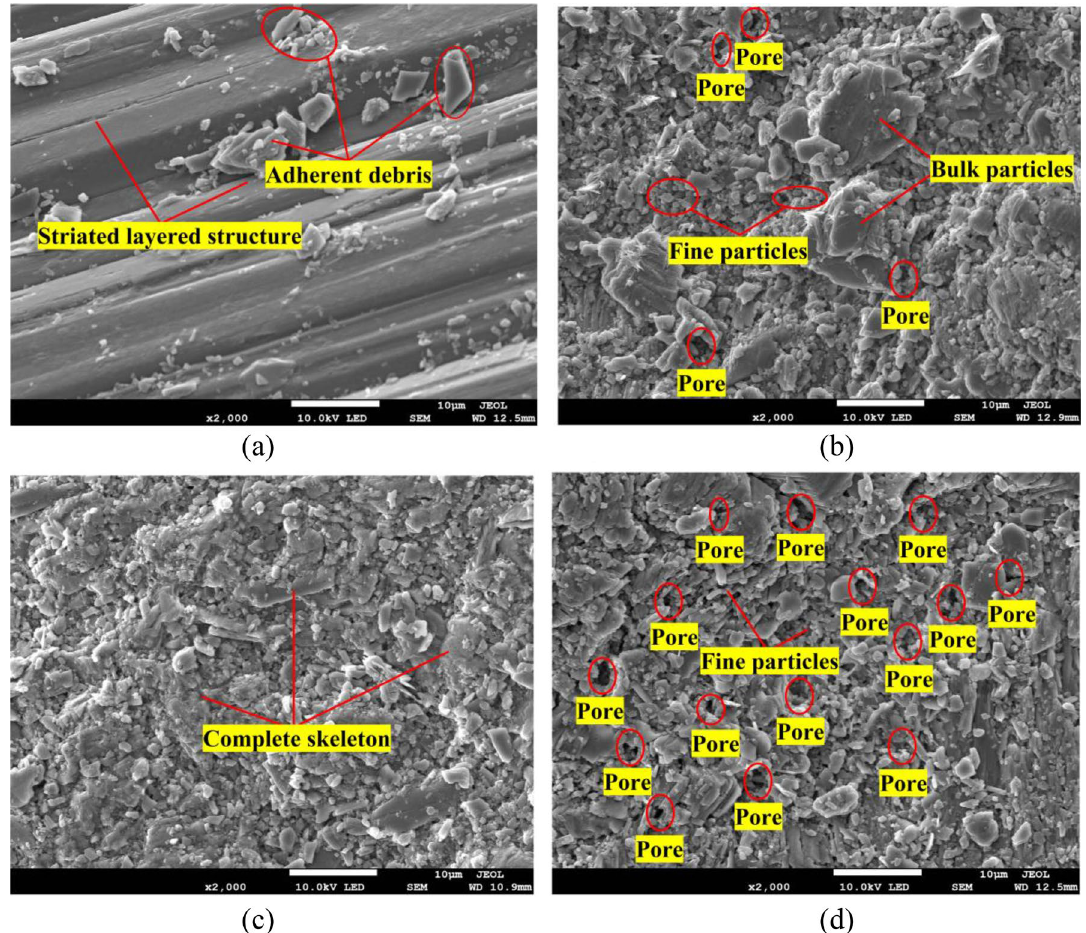
Figure 8. Microscopic failure characteristics at a magnification of 2000 for the four types of gypsum rocks investigated: ( a ) fiber gypsum, ( b ) transparent gypsum, ( c ) alabaster, and ( d ) ordinary gypsum. (The figure which is not generated by other software is just the picture obtained by the SEM test, meanwhile, the red lines and black words on yellow background are added by the Microsoft office 2016, https:// www. micro soft. com/ zh-